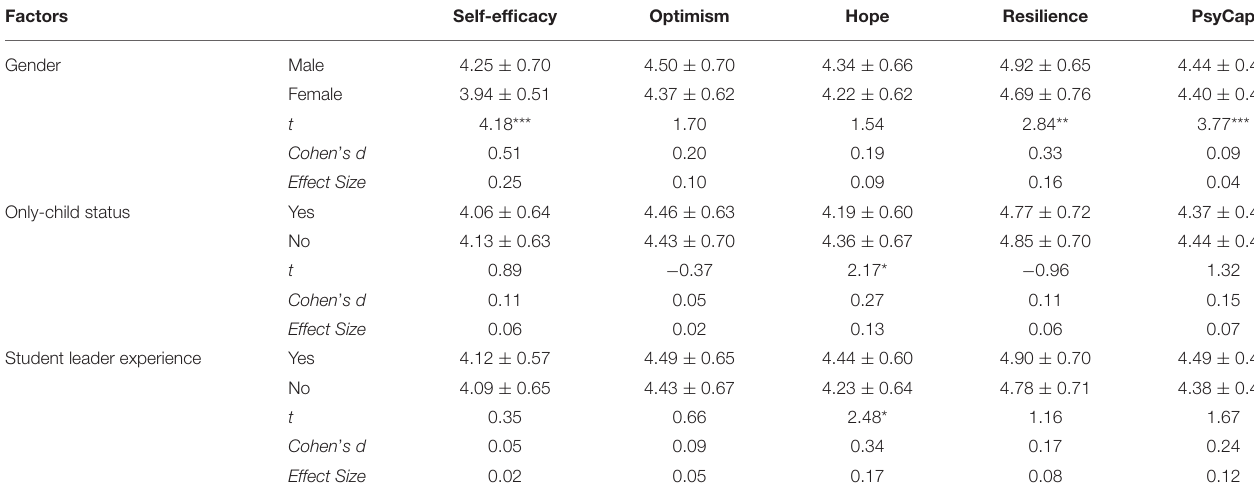
TABLE 2 | Demographic differences in USWL psychological